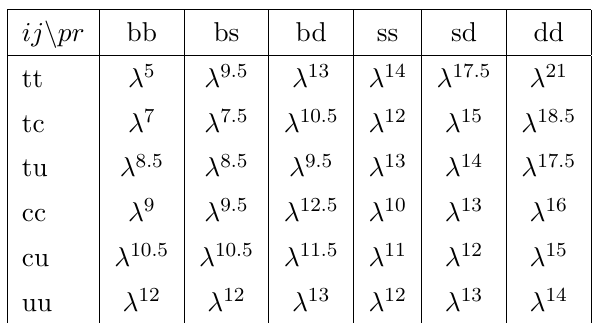
) of the mixing y d V jr y d CKM CKM p r